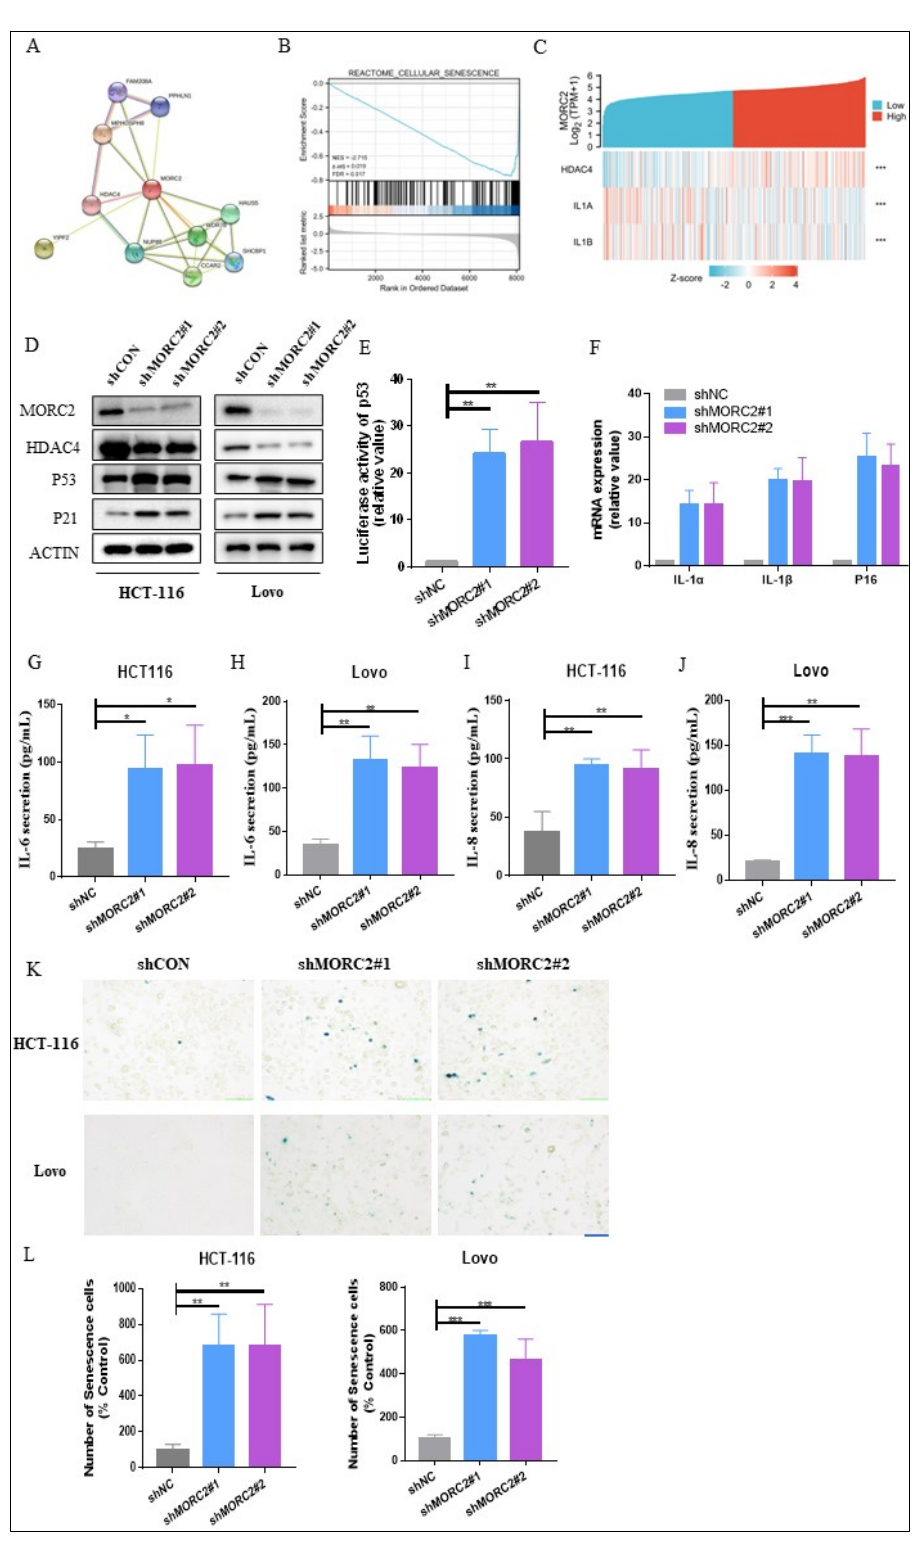
Figure 3. Knockdown of MORC2 induces cell senescence. ( A ) PPI network of the top 10 interacting genes related to MORC2. ( B ) GSEA indicates that MORC2-associated DEGs were enriched in